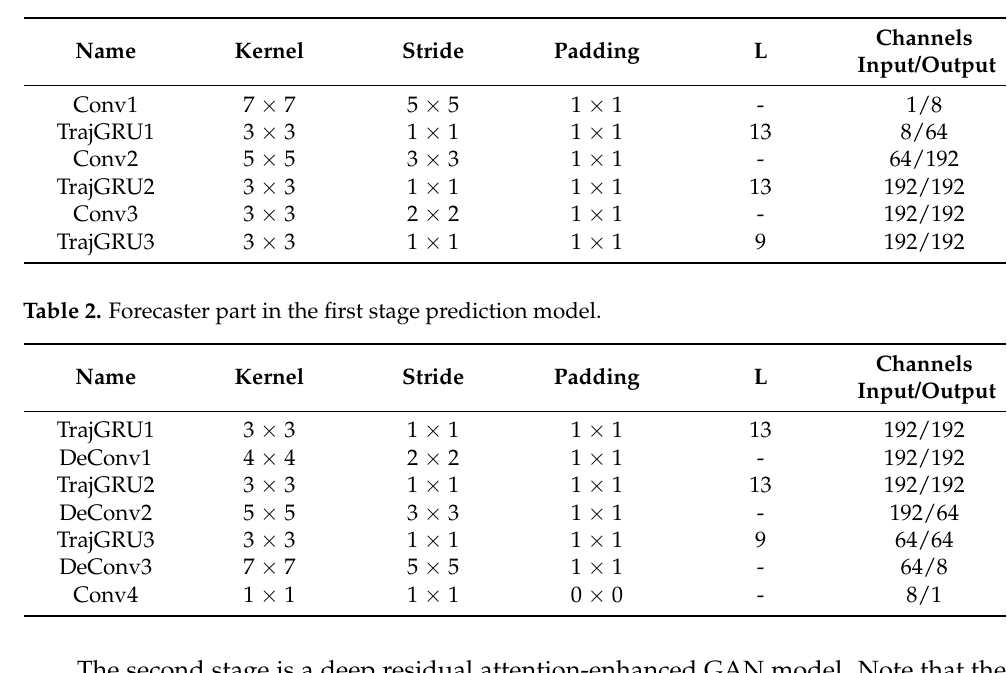
Table 1. Encoder part in the first-stage prediction model.